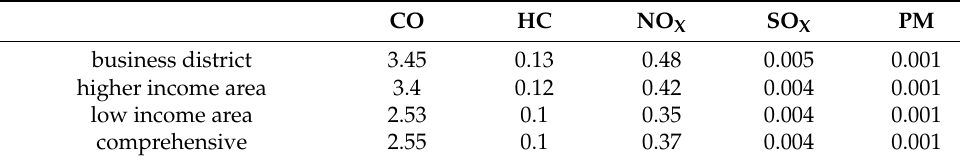
Table 6. Revised emission factors of Qingdao taxi (g/km).